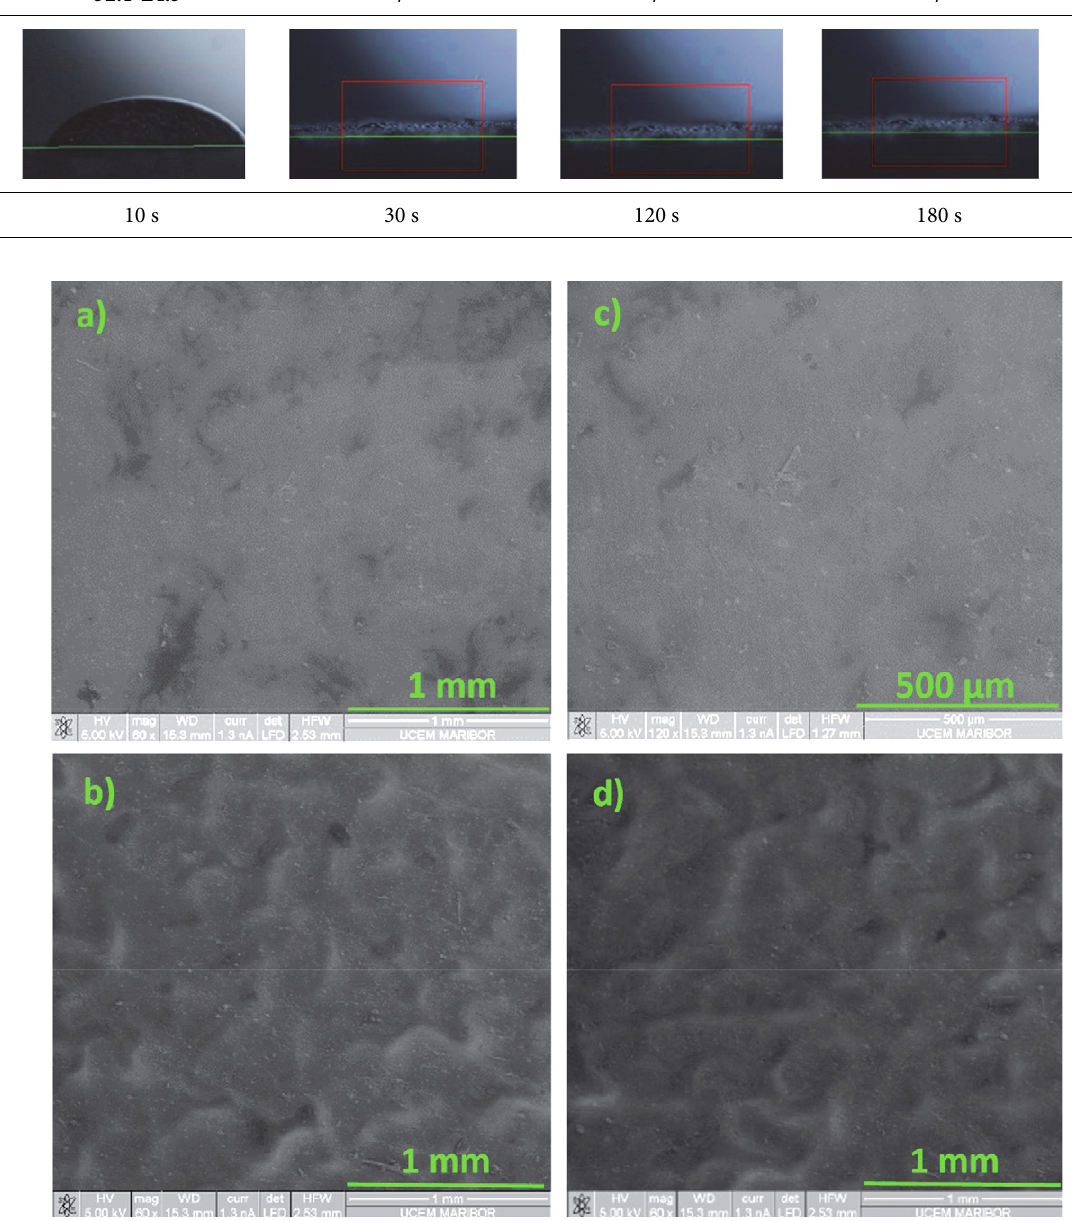
Figure 4 . Microstructure of new membranes’ upper layer (a, c) and lower layer (b,